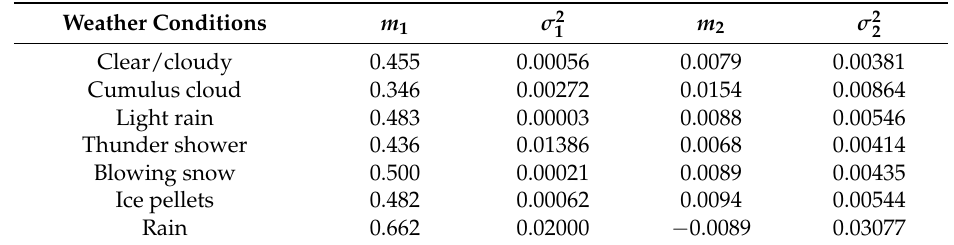
Table 1. Ka-band satellite channel envelope and phase model.